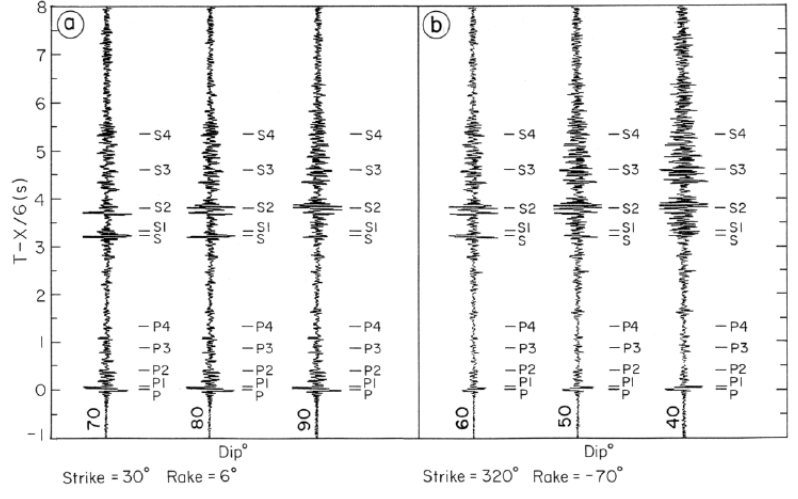
Figure 5. Same as Figure 3a showing amplitude variations due to dip angle variations for (a) strike-slip, and (b) normal mechanisms. Note higher amplitude P phases for the strike-slip